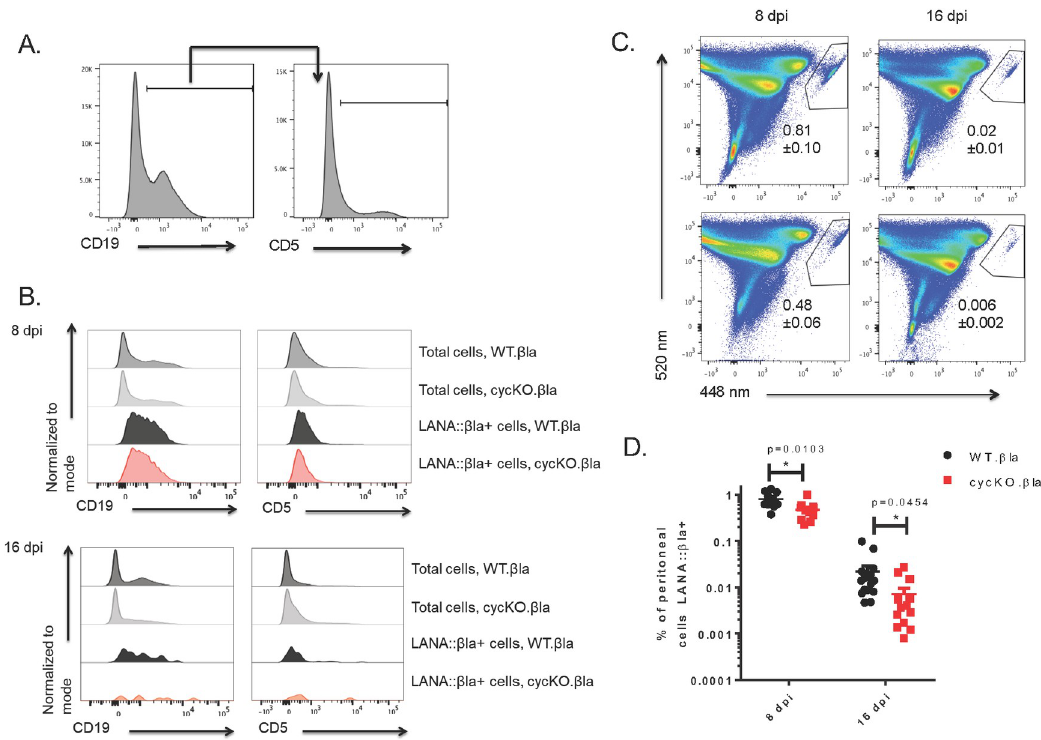
Fig 4. Disruption of the viral cyclin results in a reduced frequency of LANA:: β la expressing cells in the peritoneum of C57BL/6J mice. Mice were infected via IP injection with WT. β la or cycKO. β la viruses and peritoneal cells were harvested at 8 or 16 dpi. (A) Representative gating strategy for peritoneal cells. (B) Representative histograms of cell surface marker expression after infection with WT. β la or cycKO. β la virus on total cells (dark grey WT. β la and light grey cycKO. β la), WT. β la β la+cells (black), or cycKO. β la β la+ cells (red) at 8 dpi (top panel) and 16 dpi (bottom panel). (C) Representative pseudocolor plots identifying β la+ cells in the upper right polygon at 8 dpi (left panel) or 16 dpi (right panel) after WT. β la (top) or cycKO. β la (bottom) virus infection. The frequency of peritoneal cells that are β la+ is indicated below the gate +/- SEM. (D) Percent of cells that are β la+ with +/-SEM shown after infection with WT. β la (black) or cycKO. β la (red) virus. 8 dpi: WT. β la n = 9 and cycKO. β la n = 10.16 dpi: n = 11. Two- tailed student t tests were performed to identify statistical